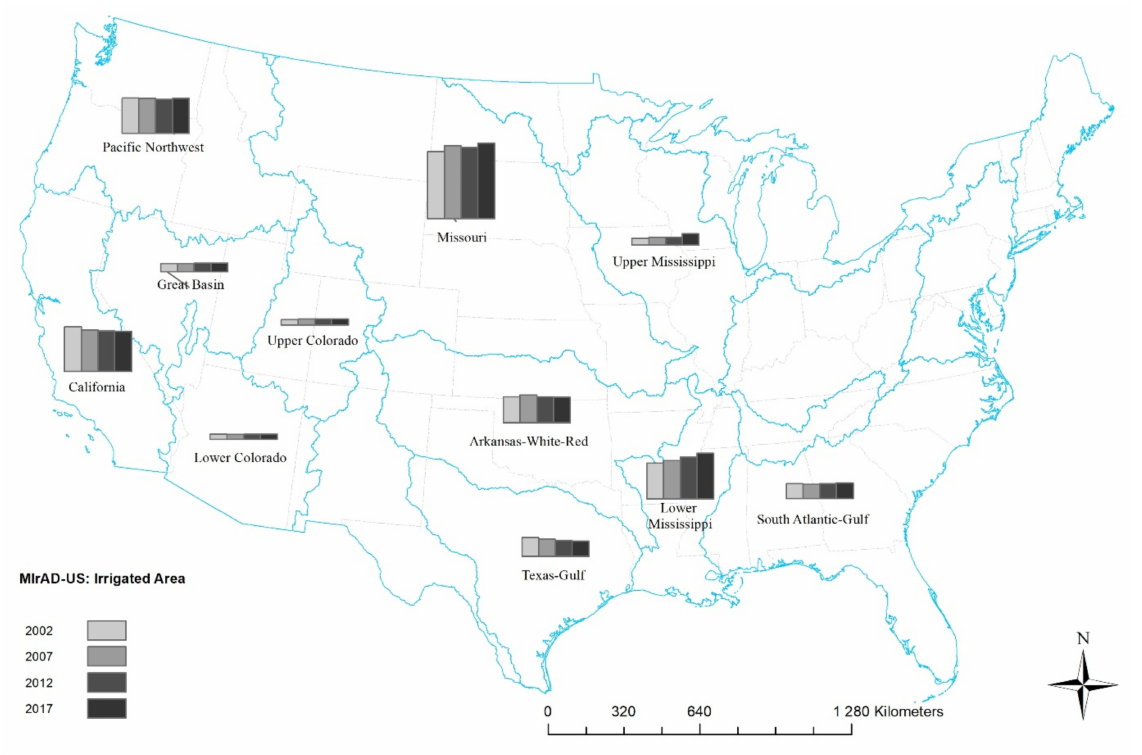
Figure 3. The graphics showing the sum of irrigated area in hectares estimated by MIrAD-US for Figure 2002. 2007, 2012, and 2017 across the CONUS at watershed boundary